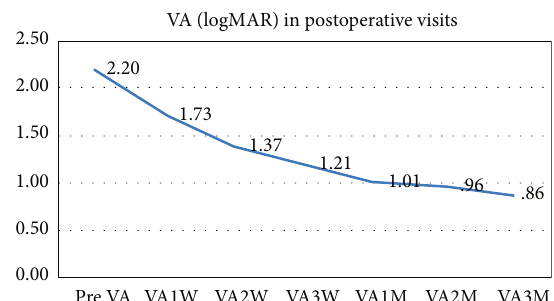
Figure 2: The change in VA (logMAR) after 1 week, 2 weeks, 3 weeks, 1 month, 2 months, and 3 months postoperatively.